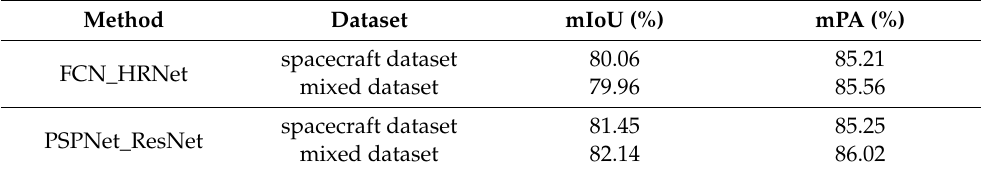
Table 3. Comparison of the validation accuracy between the mixed dataset and the spacecraft dataset training results in the real-shot validation